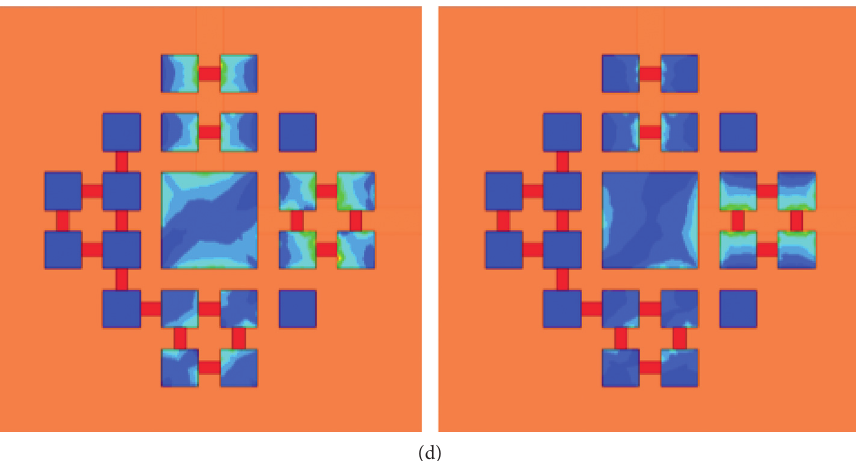
Figure 5: The optimized geometries and surface current distribution of the parasitic pixel surface with different feed ports. Beam steering direction. (a) θ � 0 ° . (b) θ yoz � 25 ° . (c) θ yoz � 45 ° . (d) θ xoz � 15 ° .